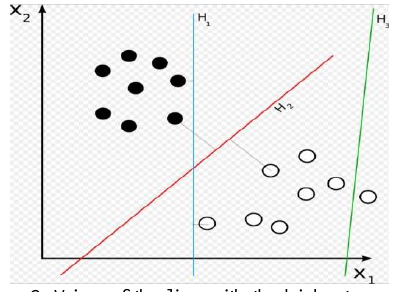
Figure2. View of the line with the highest